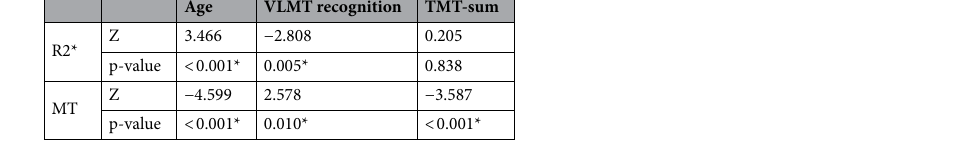
Table 2. Comparison between correlations within BG vs. SN/VTA. Significant results are highlighted with an asterisk.